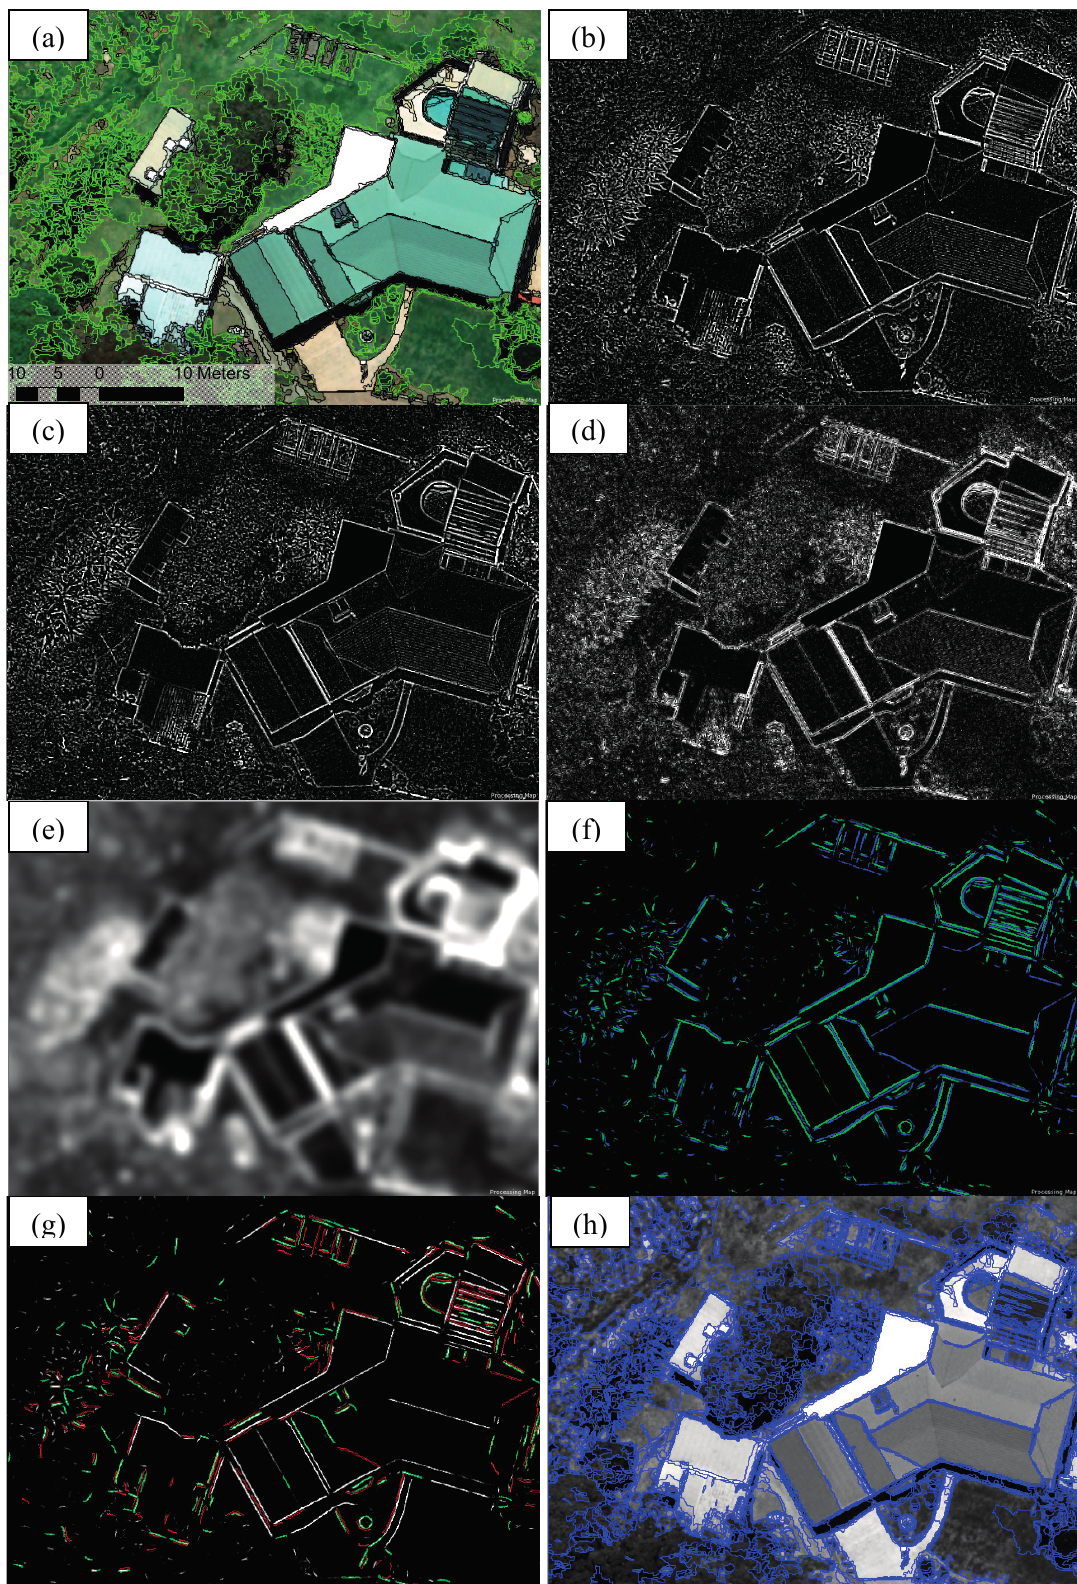
Figure 6. ( a ) Base object segmentation; ( b – d ) bright and dark edge detection; ( e ) smoothed edge detection; ( f – g ) line features; and ( h ) updated segmentation result.